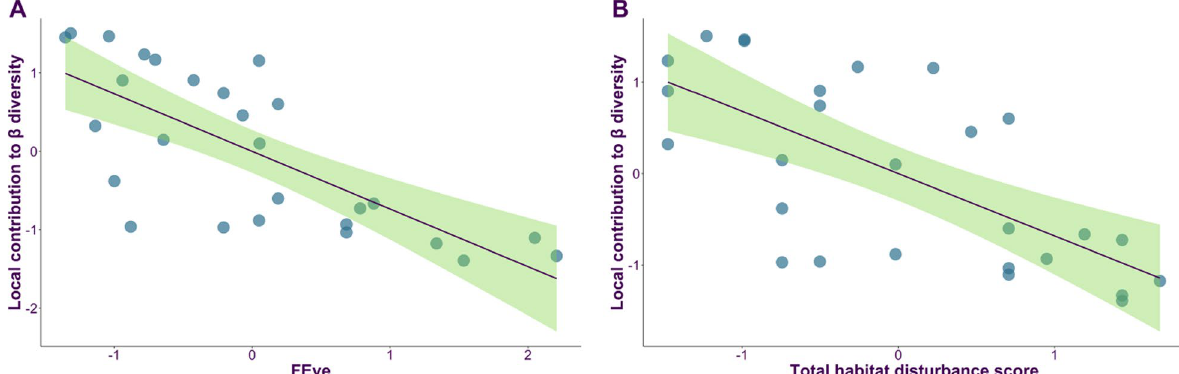
Fig. 7 Scatter plots of the relationship between A local contribution to β diversity (LCBD) and functional evenness (FEve) of spider community (multiple R 2 0.539, r 0.734) and B local contribution to β diversity (LCBD) of spider community and total habitat disturbance score (multiple = = − R 2 0.464, r 0.681) in the 27 sites studied along the Ganga River, = = −